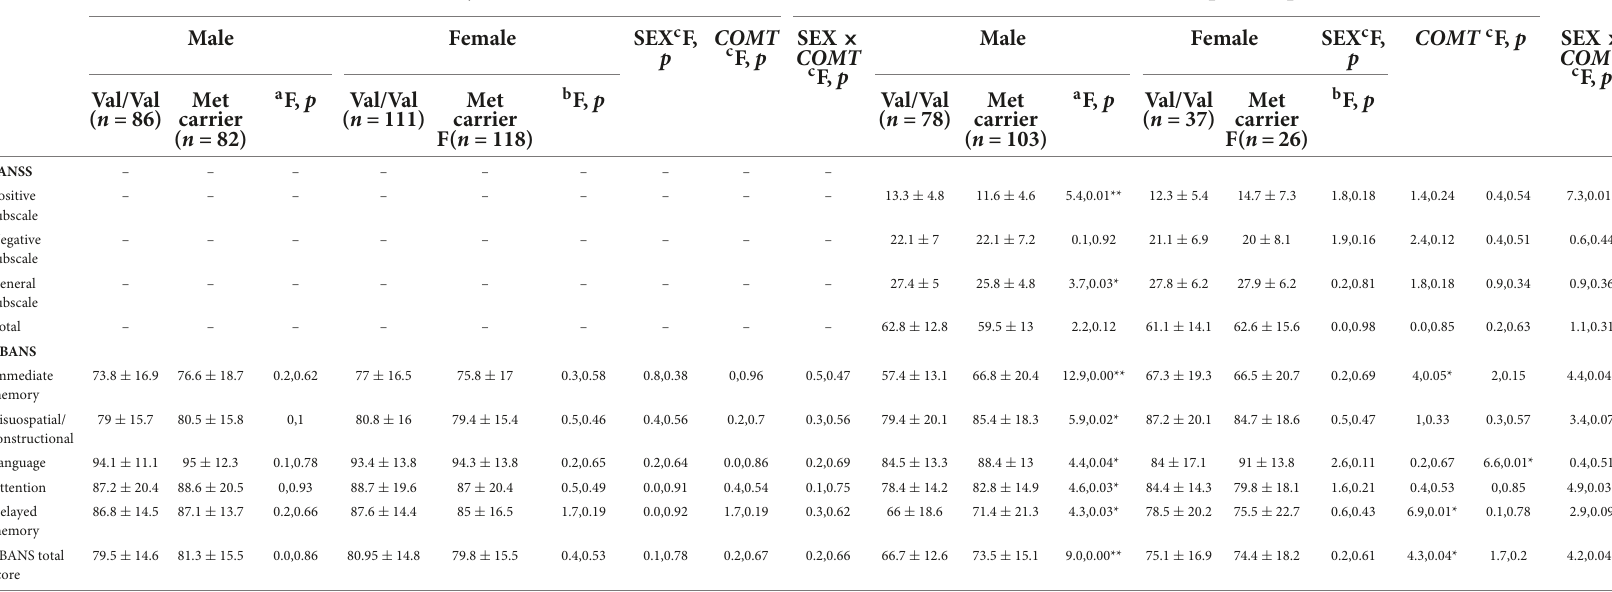
TABLE 3 Interaction of sex and COMT Val 158 Met (rs4680) genotypes on the clinical characteristics and cognitive performance in healthy controls and patients. Healthy